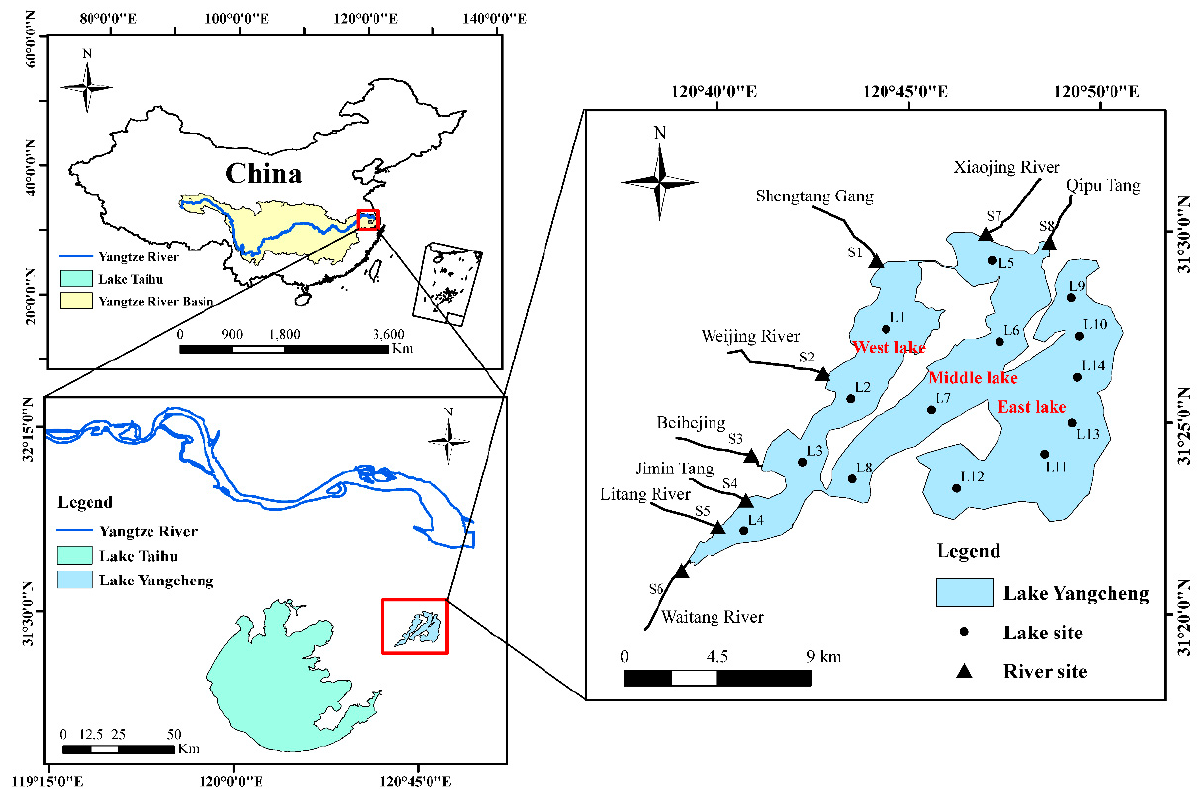
Figure 1. Maps showing the locations Lake Yangcheng in China and the sampling sites in this lake and its connected rivers (inflows) in this study.